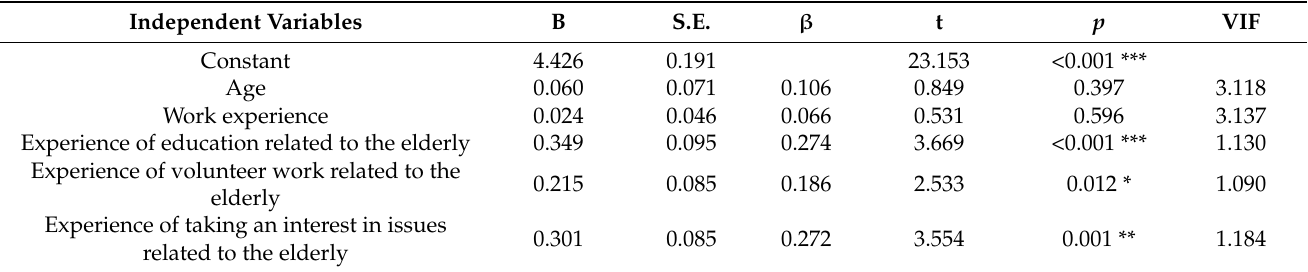
Table 7. Factors that influence the effect of experiences related to the elderly on the perception of human rights violations against the